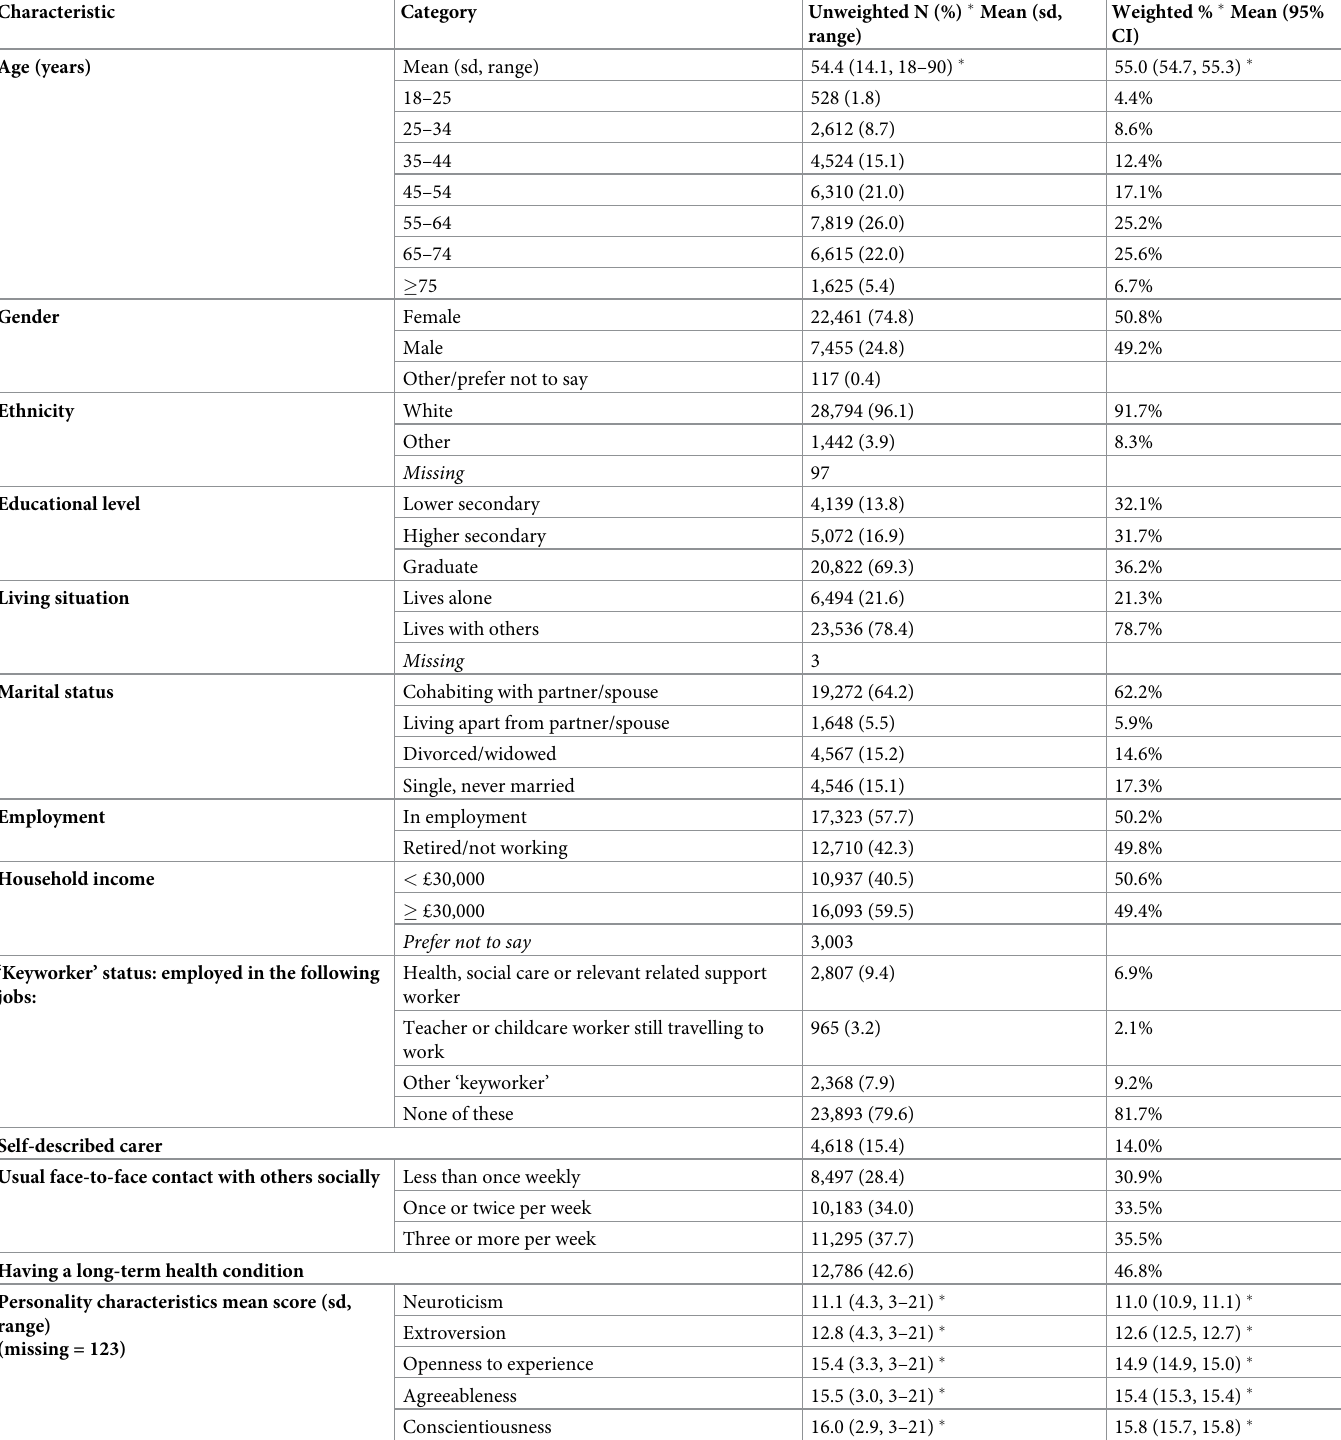
Table 2. Characteristics of the sample (n =